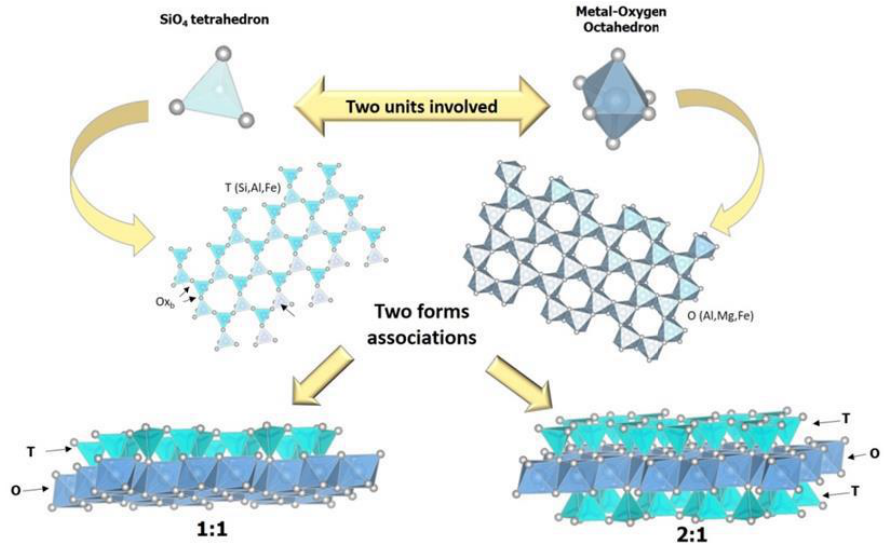
Figure 1. Representation of 1:1 (TO) and 2:1 (TOT) arrangements in clay mineral structure. Repro- duced with permission from [8].